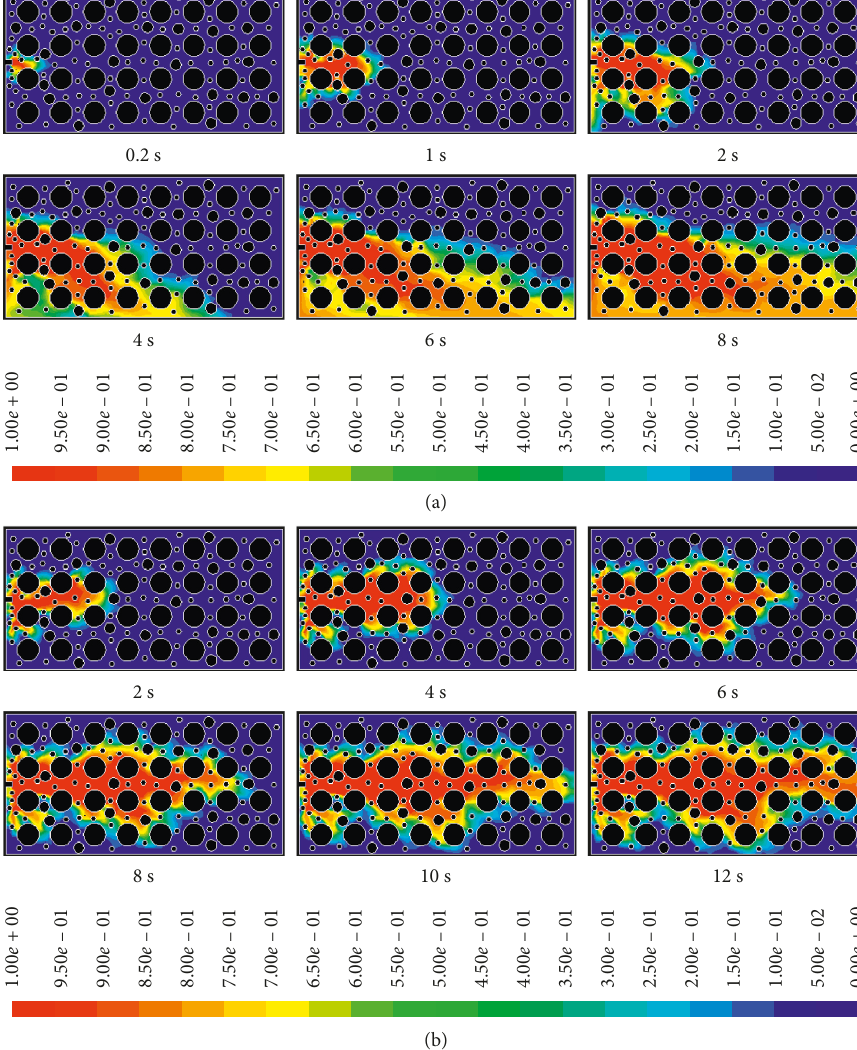
Figure 7: Migration process of water in filling structure 2 under different dynamic viscosities: (a) μ � 1N · s/m 2 ; (b) μ � 30N · s/m 2